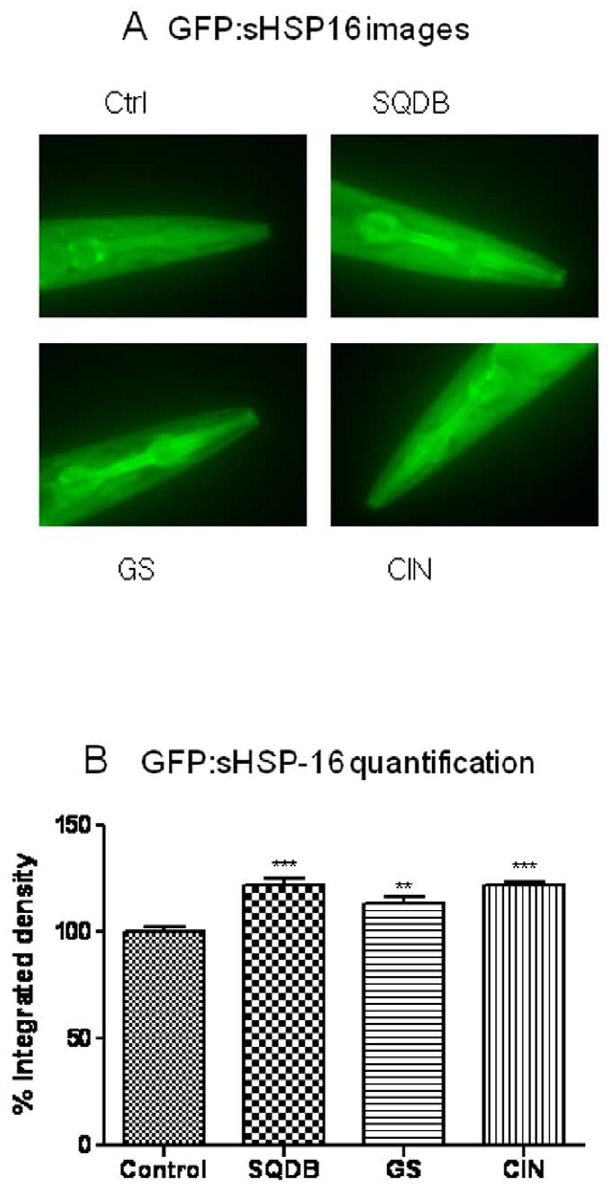
Figure 2. Representative epifluorescence image of transgenic C.elegans (CL2070, hsp-16- 2/GFP) fed with or without herbs followed by a heat-shock treatment for 2 hr. CL2070 (hsp-16-2/ GFP) worms, grown at 20 u C, were treated with vehicle control (Ctrl), SQDB (100 m g/ml), GS, CIN (10 m g/ml) for 48 h starting at 2 days of age. The worms were exposed to 35 u C for 2 h and transferred to 20 u C for